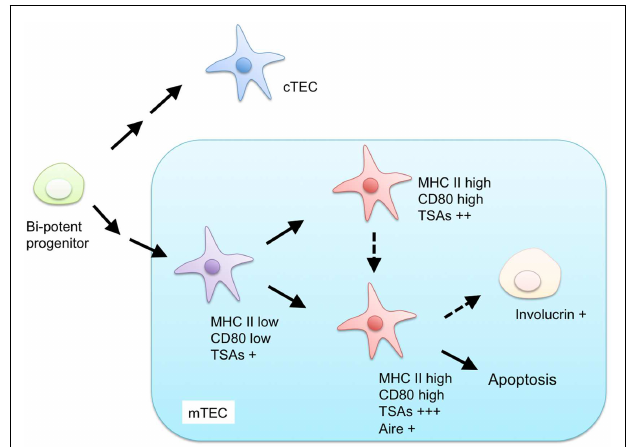
FIGURE 1 | Proposed model for differentiation of mTECs . Both mTECs and cTECs are generated from a bi-potent progenitor in the fetal and adult thymus. mTECs are classified by expression of MHC class II (MHC II), CD80, AIRE, and involucrin. mTECs expressing low levels of MHC II and CD80 are considered immature and give rise to mature mTECs, expressing high levels of MHC II and CD80, and a more diverse set of tissue-specific antigens (TSAs). MHC II-high and CD80-high mature mTECs are further separated into AIRE-positive and AIRE-negative subpopulations. AIRE-positive mature mTECs are postmitotic and undergo apoptosis or otherwise differentiate into involucrin-positive